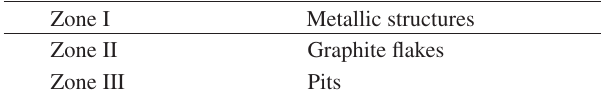
Table 1. Zones of the brake disc operating surface.